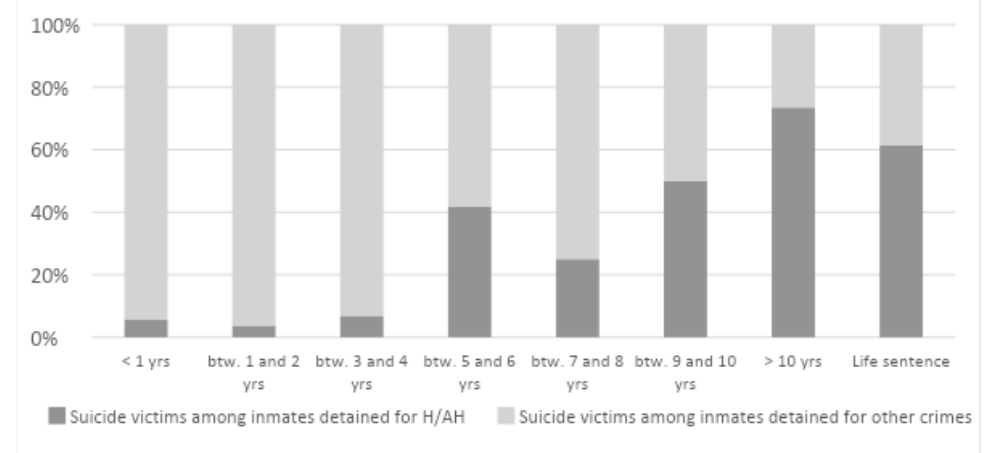
Figure 2. Suicide percentage considering the time sentence in inmates detained for other crimes or for Homicide/attempted homicide.